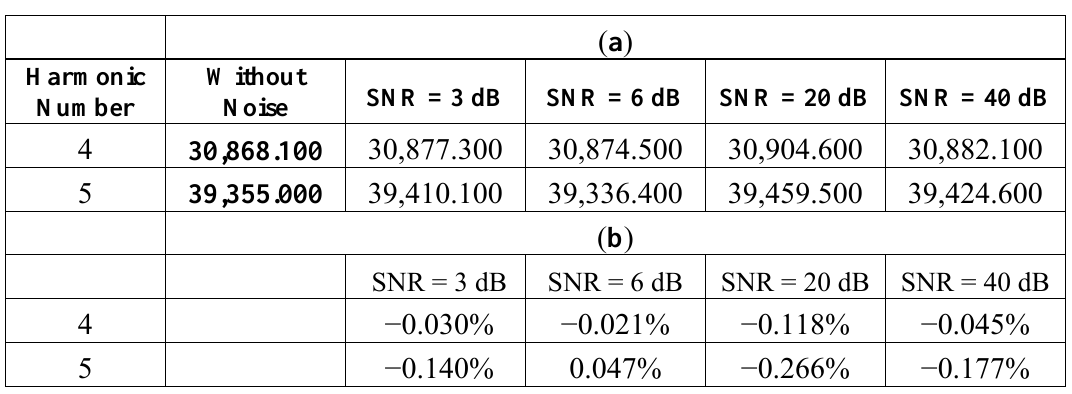
Table 1. ( a ) Values obtained by Burg method for 4th and 5th harmonic peaks of PSD (Hz); ( b ) Percentage error between signals with different level of SNR and signal without